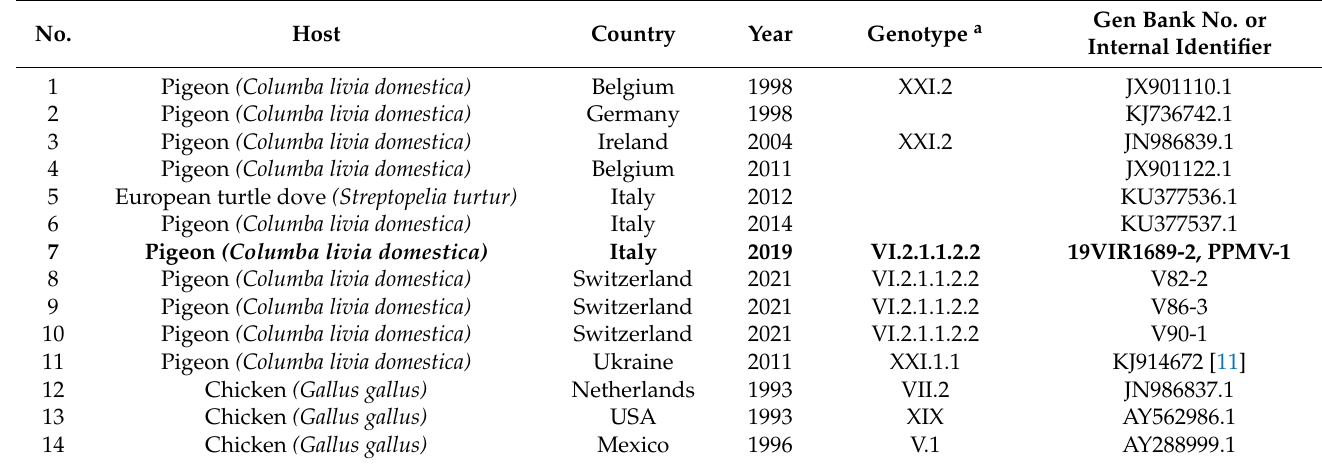
Table 1. Avian orthoavulavirus-1 isolates used for F gene sequence